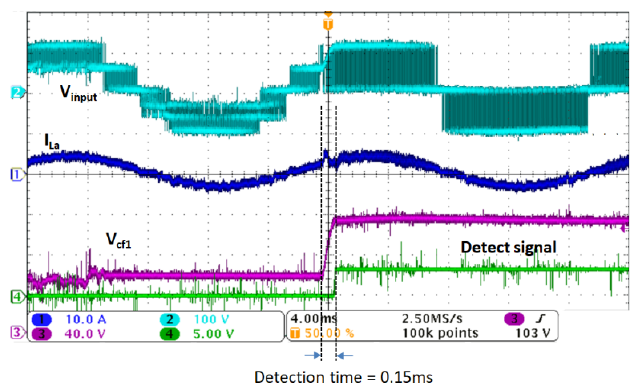
Figure 21. Experiment result for short-circuit fault condition on T 2 with the detection signal.